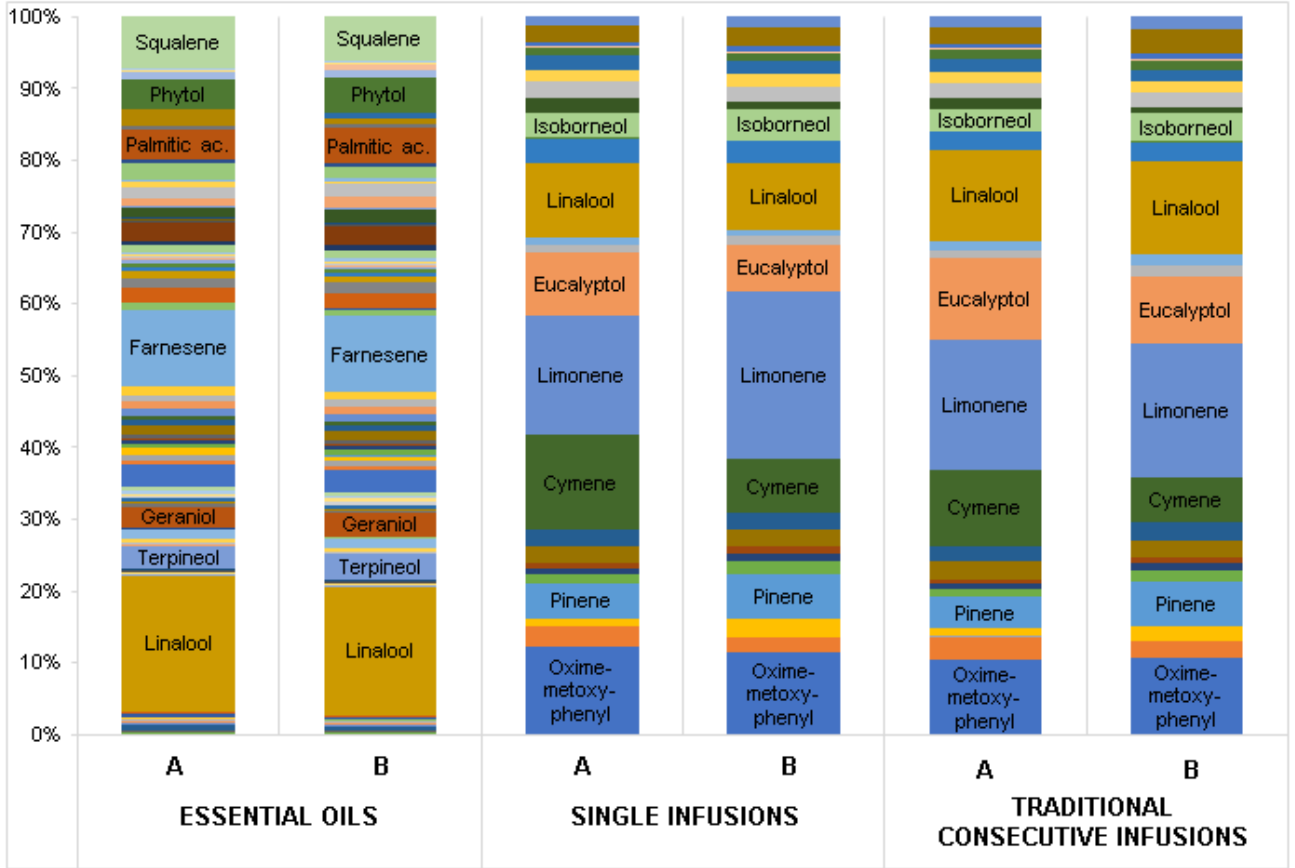
Figure 3. Relative peak areas of the volatiles (only major compounds are labeled). A—sample A; B—sample B.